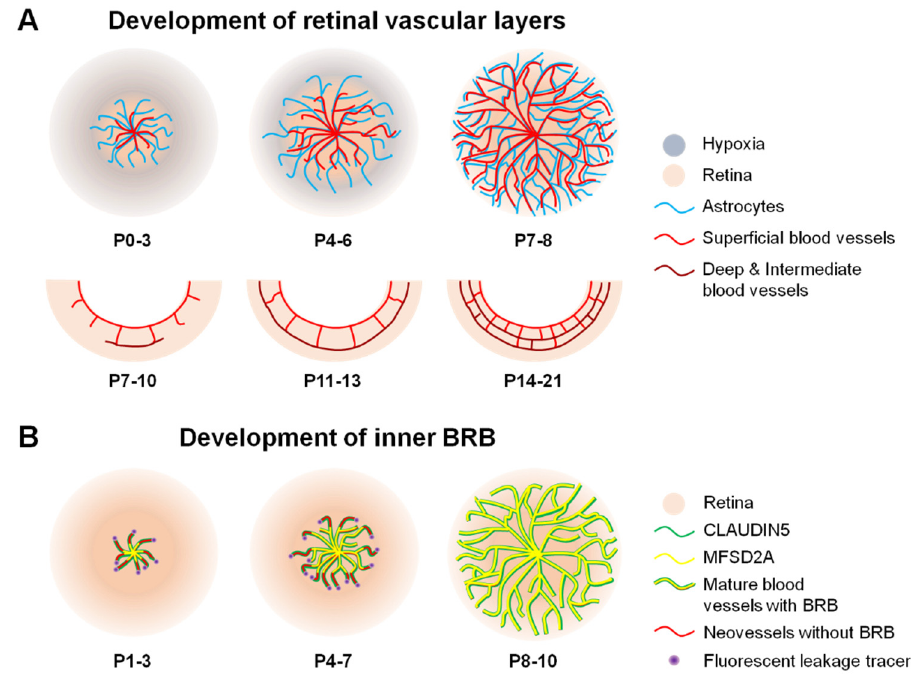
Figure 3. Scheme illustrating formation of blood vessels and inner BRB (iBRB) in the mouse retina. ( A ) In mice, vascular sprouting or angiogenesis develops after birth from postnatal day (P) 0. The retinal vessels (red) originate from the optic nerve head after birth, grow radially towards the periphery, and reach the edge of the retina around P7-8. Astrocytes (blue) precede and serve as a template for the newly developing retinal vessels. Superficial vascular plexus follows a hypothesized physiological hypoxia wave (grey) and astrocyte template (blue). Complete formation of superficial vasculature is followed by development of deep vessel formation during the second week of birth and subsequent formation of an intermediate vascular layer. The whole retinal vasculature growth takes approximately three weeks after birth in mice. In humans, this process occurs prenatally. ( B ) Formation of the iBRB proceeds in a central-to-peripheral pattern in the retina, beginning with the presence of tight junctional protein claudin5 (green) as early as P1, which matures by P3 to cover the entire length of newly formed vessels in mice. However, these new sprouting neovessels are still leaky (red) and injected fluorescent leakage tracers (purple) can be detected around neovessels. From P3 onward, the full length of these vessels starts to be lined with the transcytosis modulating protein, MFSD2A (yellow). This process continues through P10, at which point the superficial retinal vasculature has completely formed and matured along with the BRB. BRB, blood–retinal barrier; MFSD2A, major facilitator superfamily domain-containing protein 2a. Figure adapted with permission from Chen et al., Anti-Angiogenic Therapy in Ophthalmology , 1–19, Springer